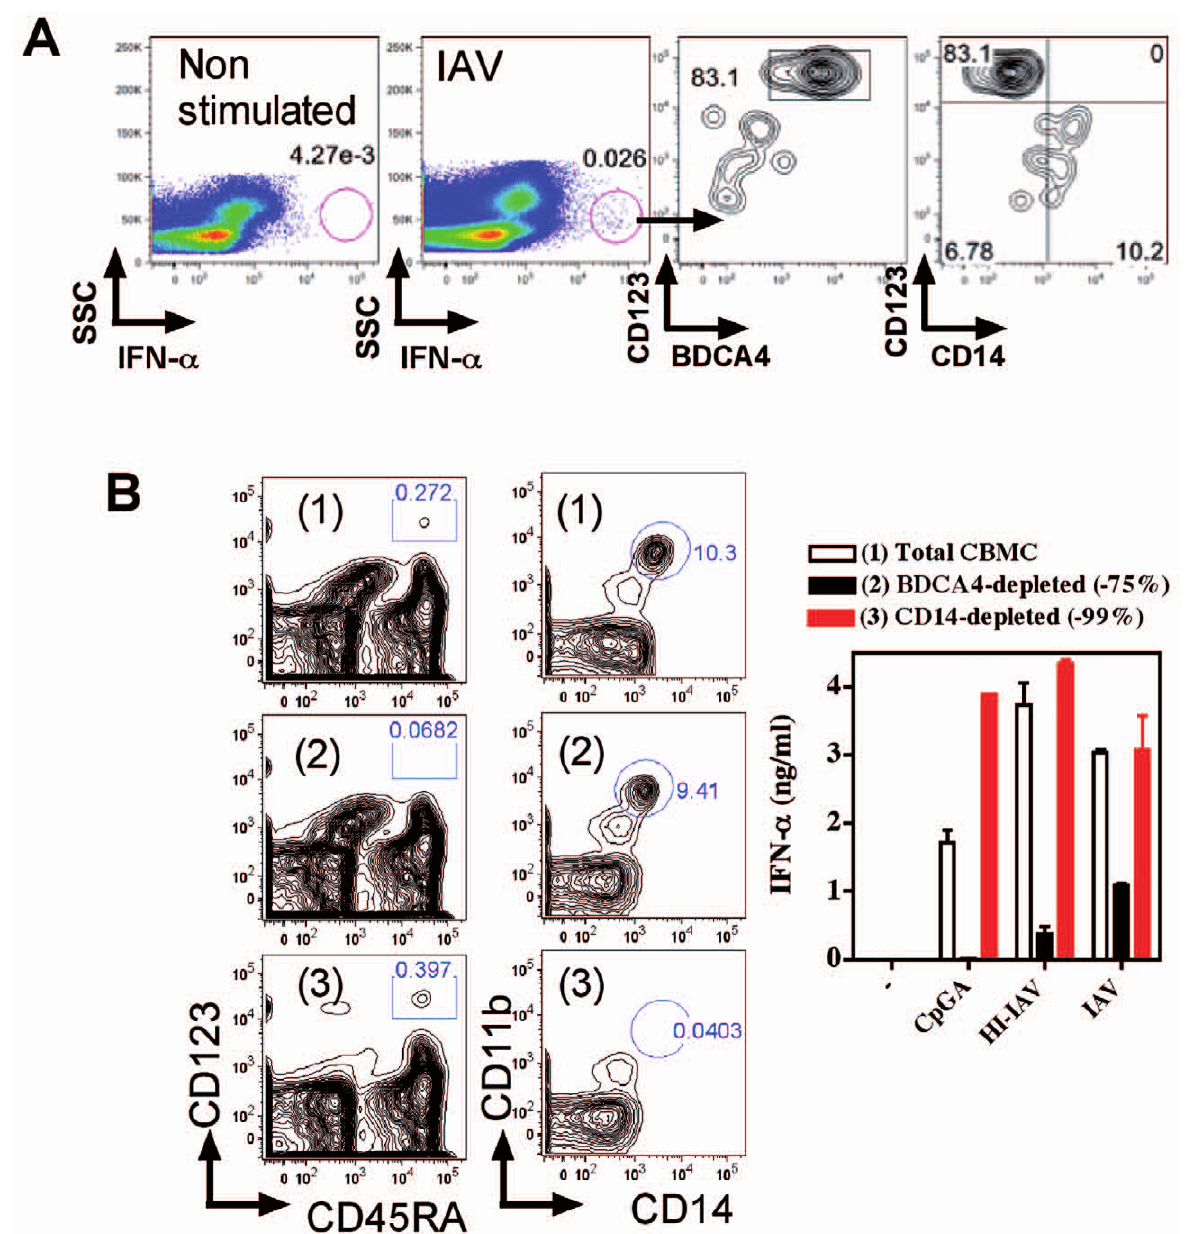
Figure 2. Cord blood pDCs are the main contributor for IFN- a response. (A) Neonatal cord blood was left untreated or exposed to IAV, for 6 hrs and stained intracellularly for IFN- a . pDCs are identified by CD123 and BDCA4 and monocytes by CD14 expression. (B) Total CBMC (1), or CBMC depleted of pDCs (2) or of monocytes (3) were stimulated with CpGA, live IAV and HI-IAV as in Fig. Plasma or supernatants were collected and tested for IFN- a (A). Depletion efficiency is shown for pDCs identified by CD123 and CD45RA and monocytes by CD14 and CD11b expression. One experiment representative of three is shown. sorted as CD2 + and CD2 2 . Purified pDCs and subsets were routinely more than 99% pure.